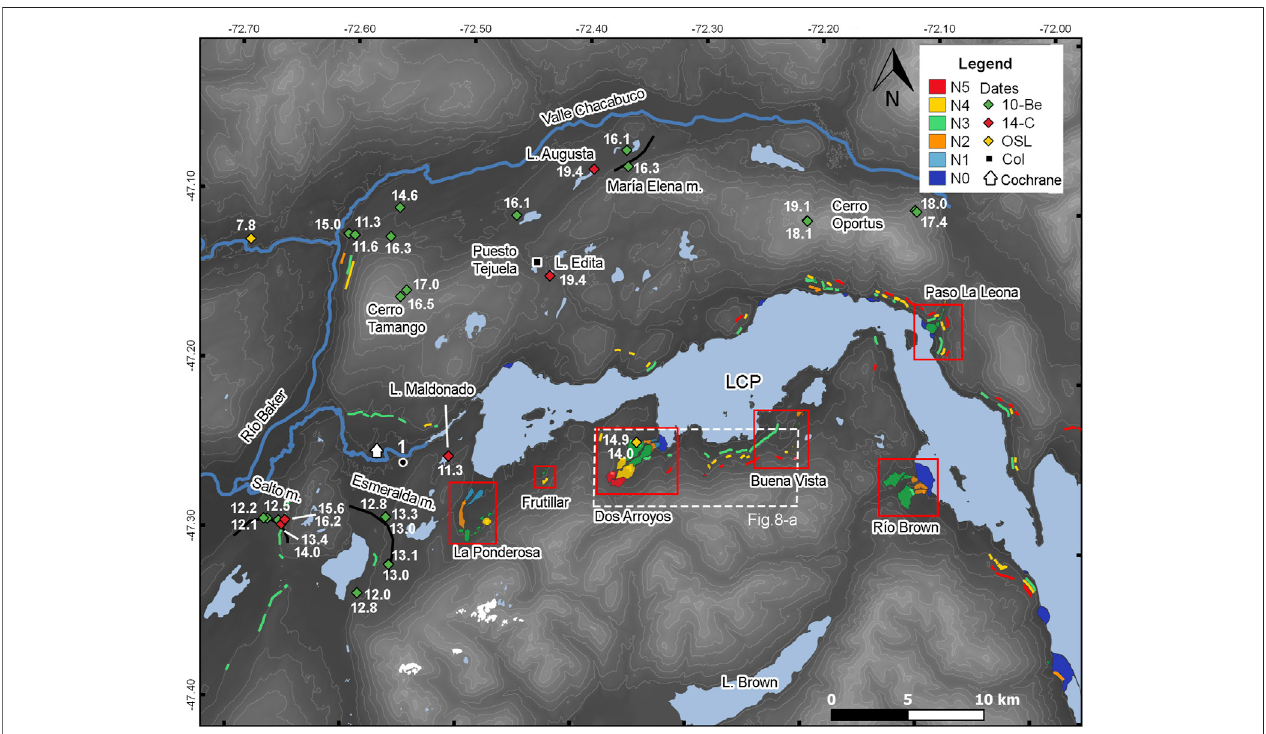
FIGURE 3 | Distribution of shoreline-related landforms in the western sector of LCP, grouped according to their elevation in N5 ( ∼ 600 – 500 m), N4 ( ∼ 470 – 400 m), N3 ( ∼ 360 – 300 m), N2 ( ∼ 230 – 220 m), N1 ( ∼ 180 – 170 m), and N0, which correspond to active deltas. Lines represent paleo-shorelines (beaches, wave-cut scarps and benches,anddeltabrink-points)andpolygonsdeltas.Geochronologicaldataareshowninka,withoutuncertainty(seedetailsin SupplementaryTablesS1 – S3 ).Black linesrepresenticelimits.Site1( Table1 )isshownasblackcircle.Redpanelsshowsectorswith fi eldrecognition(see SupplementaryFigureS7 formoredetails).